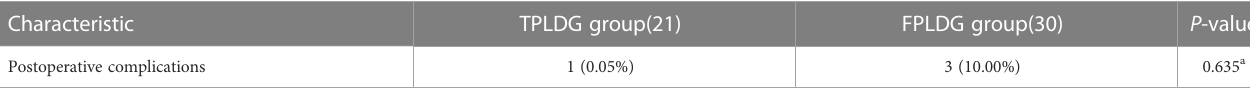
TABLE 2 Comparison of postoperative complications between the TPLDG and FPLDG groups.